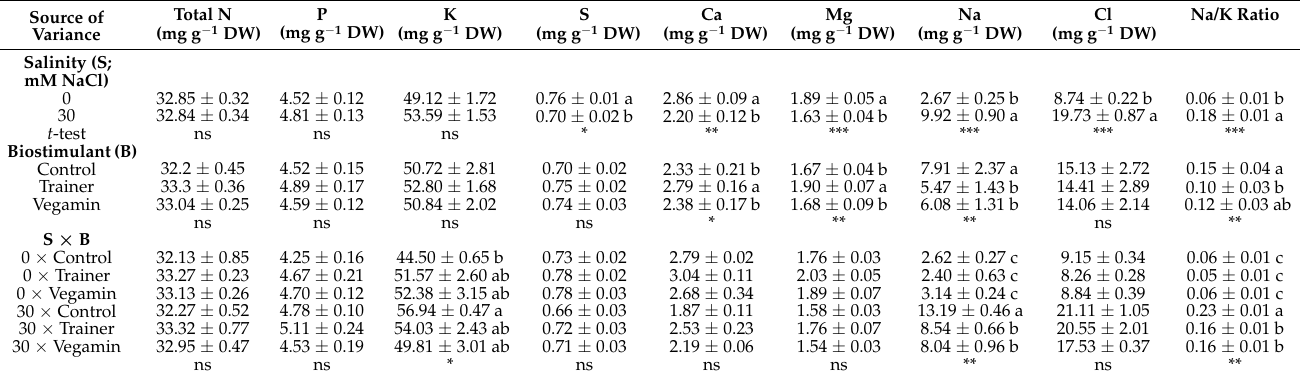
Table 3. Mineral contents of lettuce leaves as affected by salinity and biostimulant application.